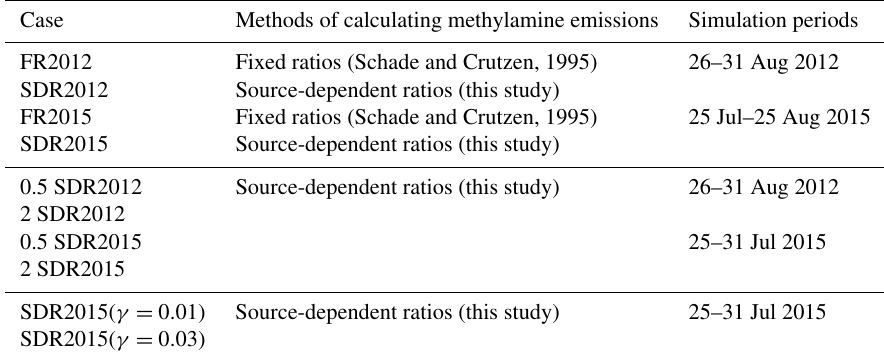
Table 2. Simulation cases in the study.